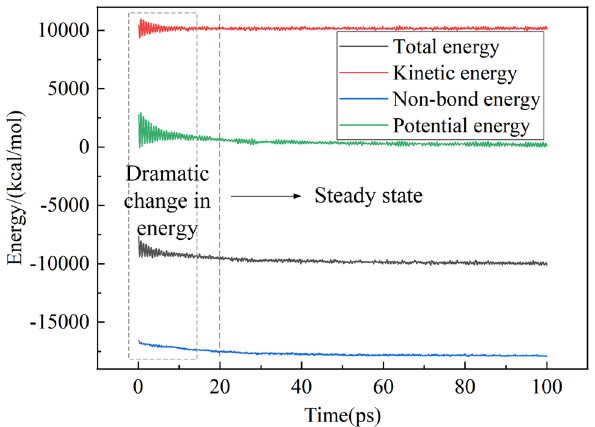
Figure 11: Forcite